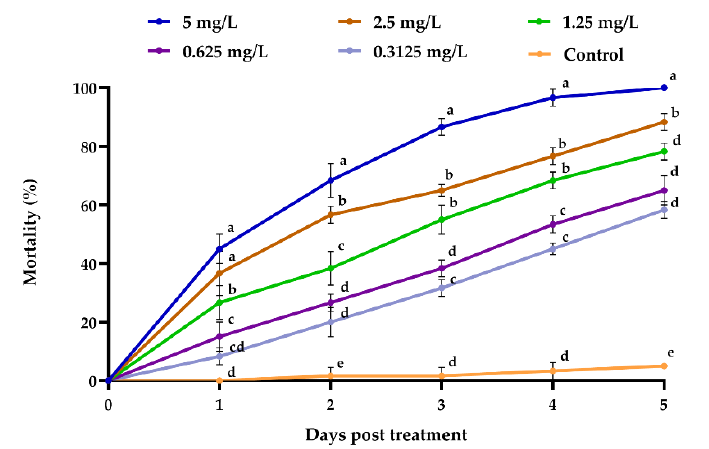
Figure 3. Mortality (%) of M. usitatus ( N = 3) challenged with various emamectin benzoate concentra- tions at different time intervals. The standard error of the means (three replicates) is indicated by the error bars. Bars showing different letters were significantly different from one another on different days after treatment.